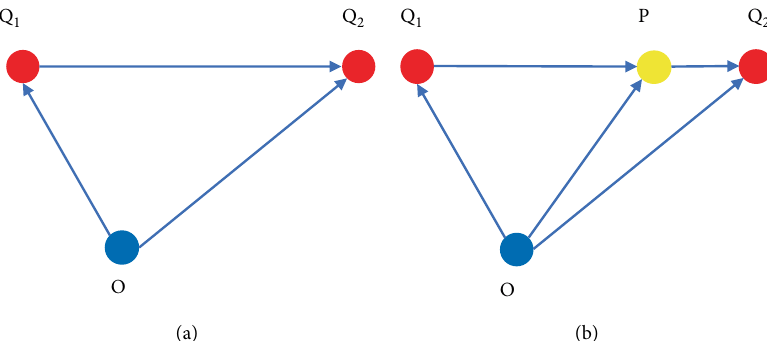
Figure 15: Schematic diagram for the derivation process of Formula (B.6). (a) Original condition. (b) Add the point 𝑃 on the line 𝑄